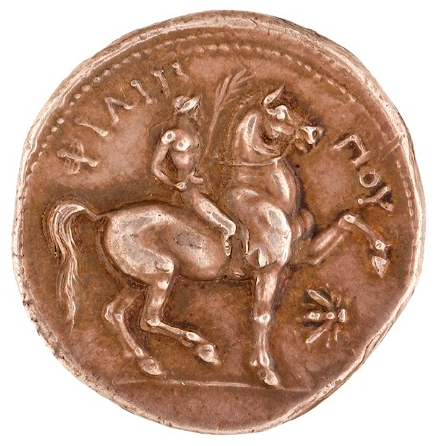
Figure 9. Silver Tetradrachm issued by Philip III Arrhide-us, c. 323-315 BCE. American Numismatics Society, 1964.42.22.